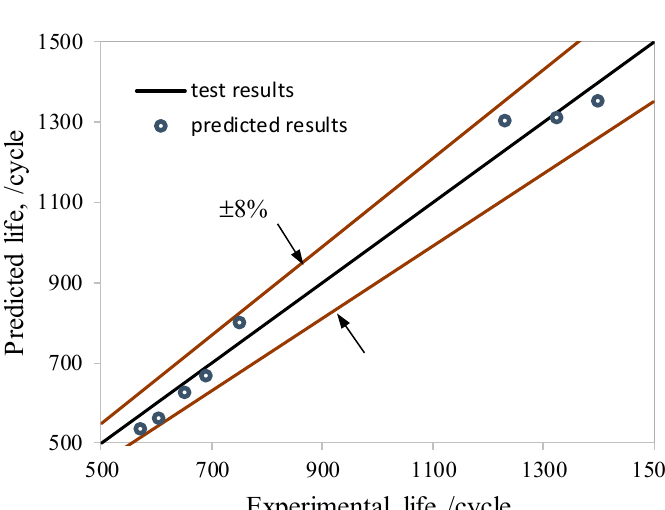
Figure 16. Error band scatter of the predicted thermal fatigue lives with the GA-BP method.